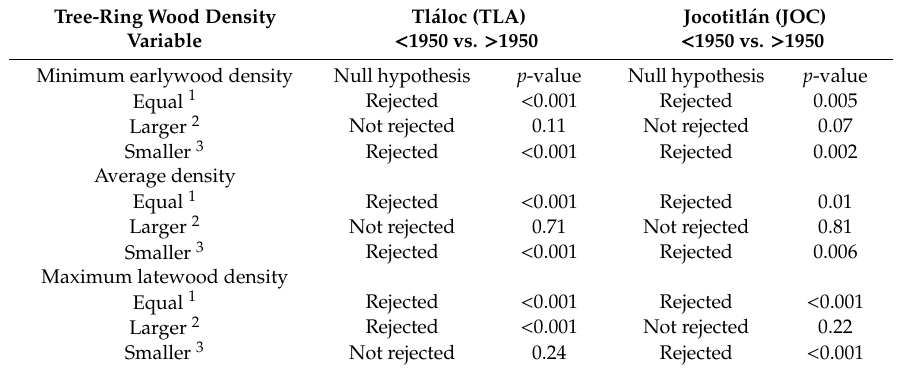
Table 3. Comparison of empirical cumulative distribution functions (CDF) between two periods ( < 1950 and > 1950) for tree-ring wood density variables according to Kolmogorov–Smirnov tests. Tree-Ring Wood Density Tl á loc (TLA) < 1950 vs. > Variable